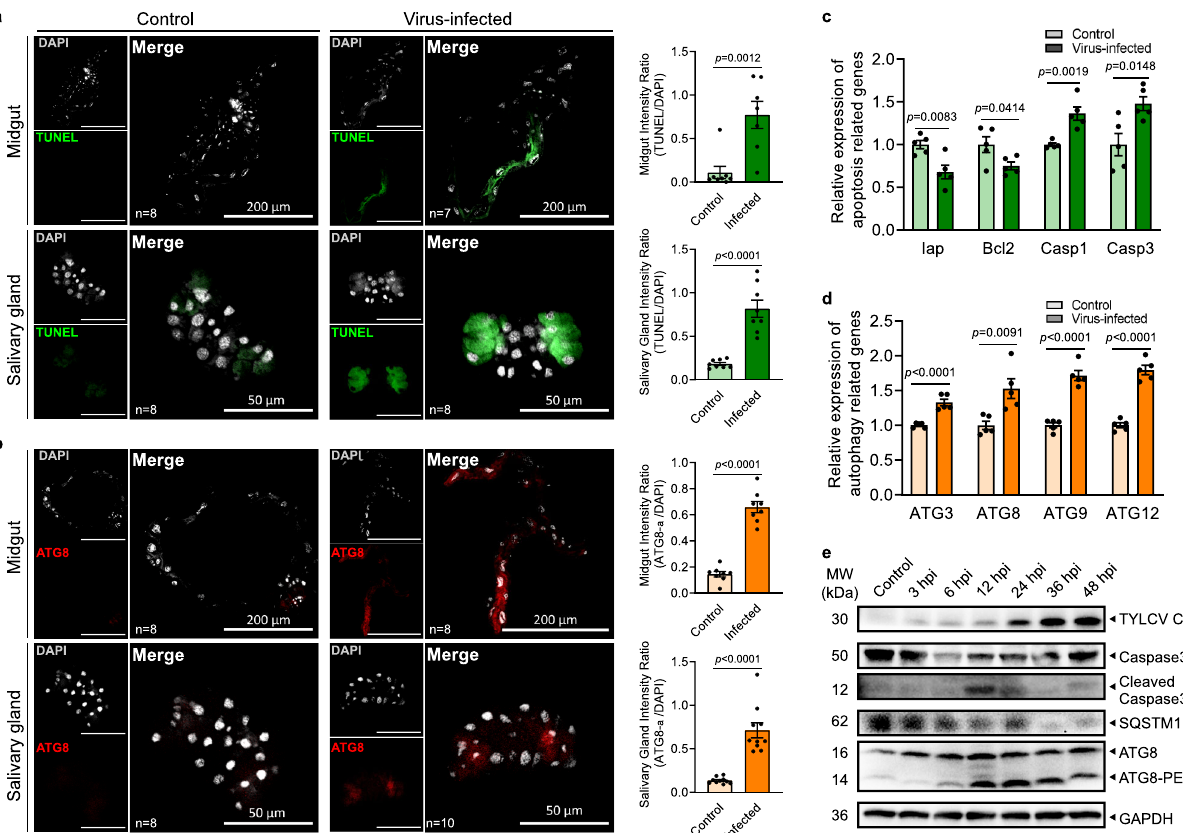
Fig. 1 Apoptosis and autophagy were simultaneously induced in white fl y when acquiring TYLCV. Midguts and salivary glands were dissected from nonviruliferous and viruliferous white fl y, respectively. a Apoptosis was determined by TUNEL assays (green), and b autophagy was indicated by the hallmark ATG8-PE (red). The nuclei (white) were stained by DAPI. Sample sizes ( n ) for statistical tests indicated in the panels refer to biologically independent white fl y. Relative intensity was quanti fi ed by ImageJ. White fl ies feeding on TYLCV-infected plant for 24 hours were sampled. The